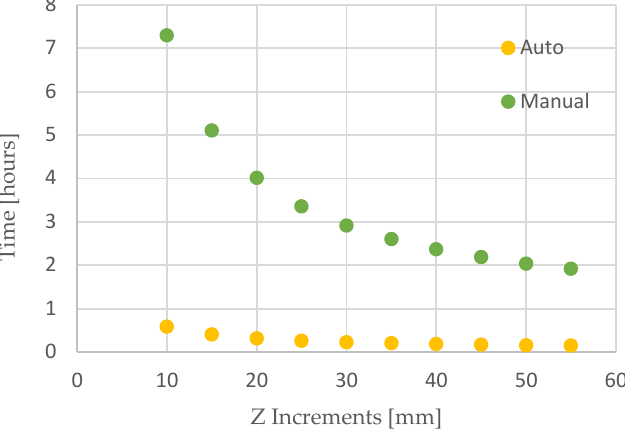
Figure 25. Influence of Z -axis increments with constant 25 mm X increments.